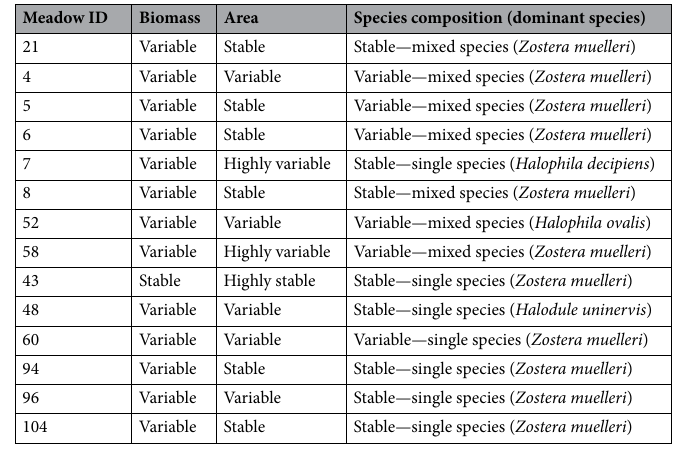
Table 3. Classifications representing the historical variability of seagrass condition 10-year baselines for biomass, area and species composition for each monitoring meadow (see Fig. 5 for map of zones).